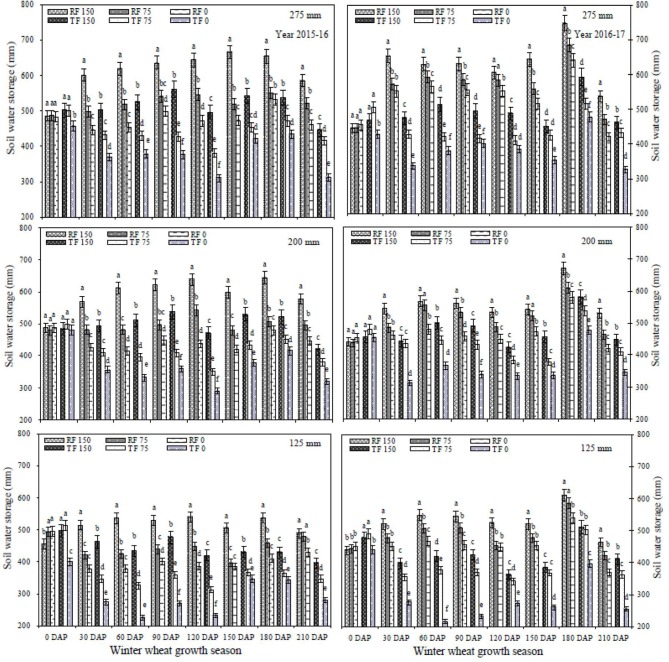
Variations in soil water storage in the soil water content dynamics in 0–200 cm layers with different treatments at different days after planting during 2015–2017. RF150: ridges covered with plastic film mulch and 150 mm deficit irrigation; RF75: ridges covered with plastic film mulch and 75 mm deficit irrigation; RF0: ridges covered with plastic film mulch and 0 mm deficit irrigation; TF150: traditional flat planting and 150 mm deficit irrigation; TF75: traditional flat planting and 75 mm deficit irrigation; TF0: traditional flat planting and 0 mm deficit irrigation. Three different simulated rainfall intensity 275, 200, and 125 mm were used. Different lowercase letters indicate significant differences at P < 0.05, and the vertical bars represent the standard error of the mean (n = 3).